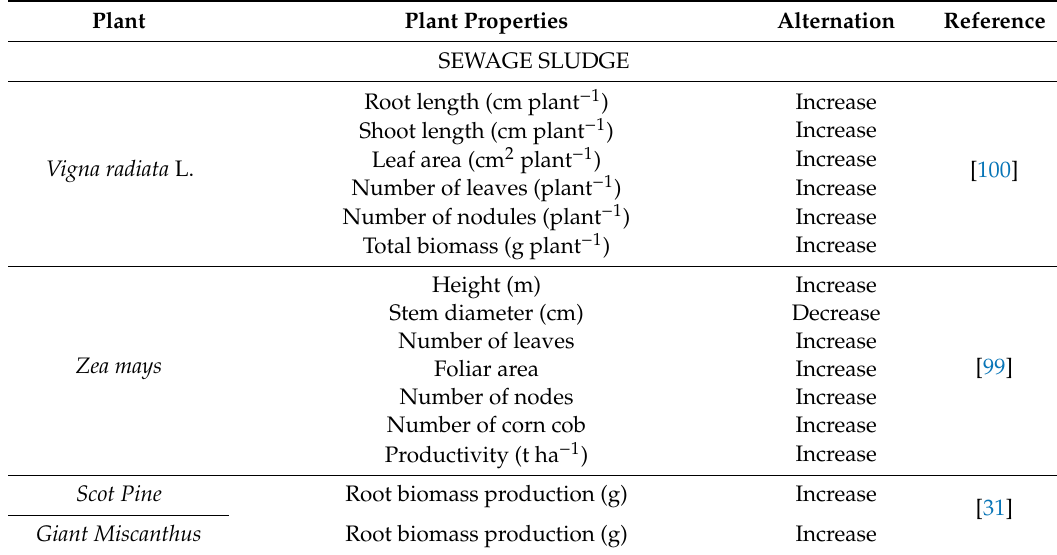
Table 3. E ff ects of sewage sludge and compost on various plant growth, development, and yield.